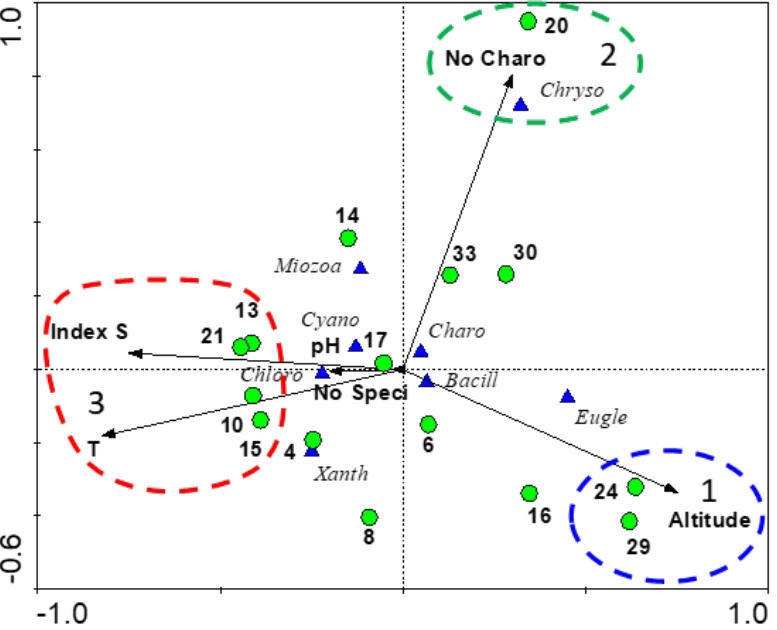
Figure 10. CCA plot of the relationships between environmental variables, index of organic pollution S, and species number in taxonomic phyla and number of charophyte species in community (blue arrows).